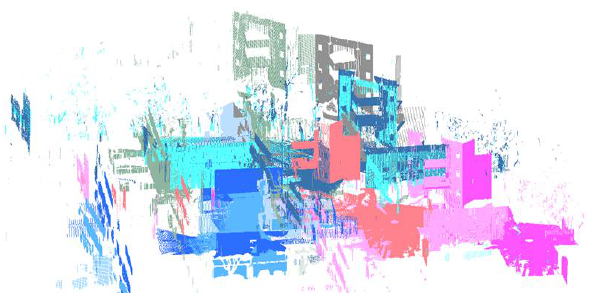
Figure 2. Connected graph with edges and nodes.